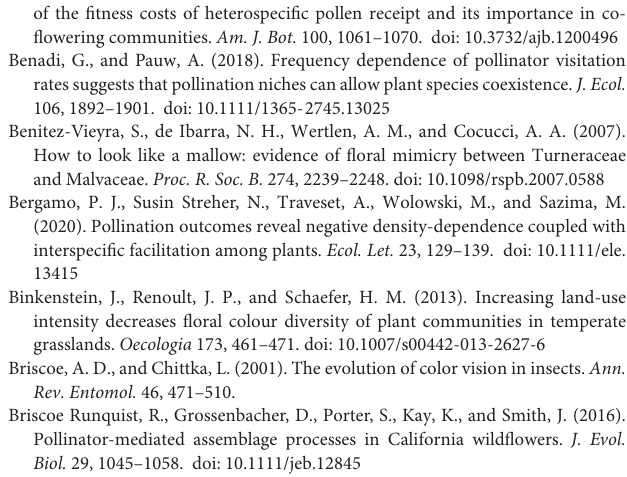
Supplementary Figure 1 | Results of principal component analysis. (A) Proportion of variation explained by each Principal Component axis, with dashed